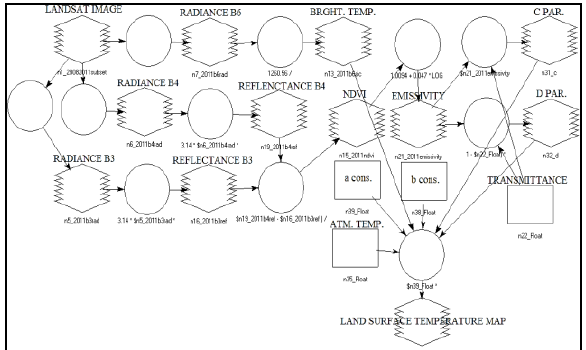
Figure 2. LST image model created in Erdas Imagine Spatial